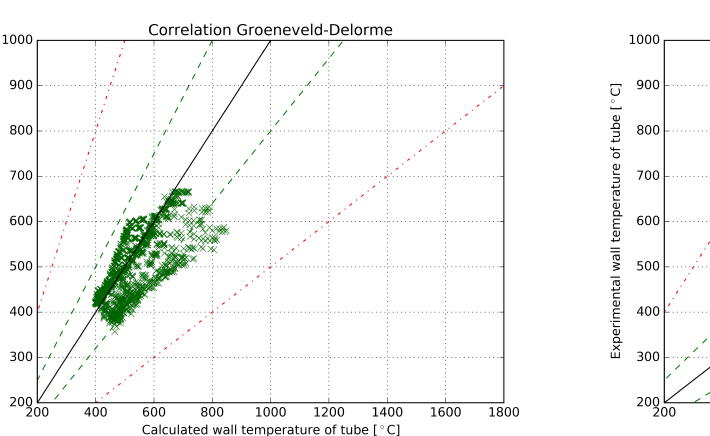
Figure 4. Comparison of experimental and calculated values of wall temperature with reduced data base for the values of smallest mass